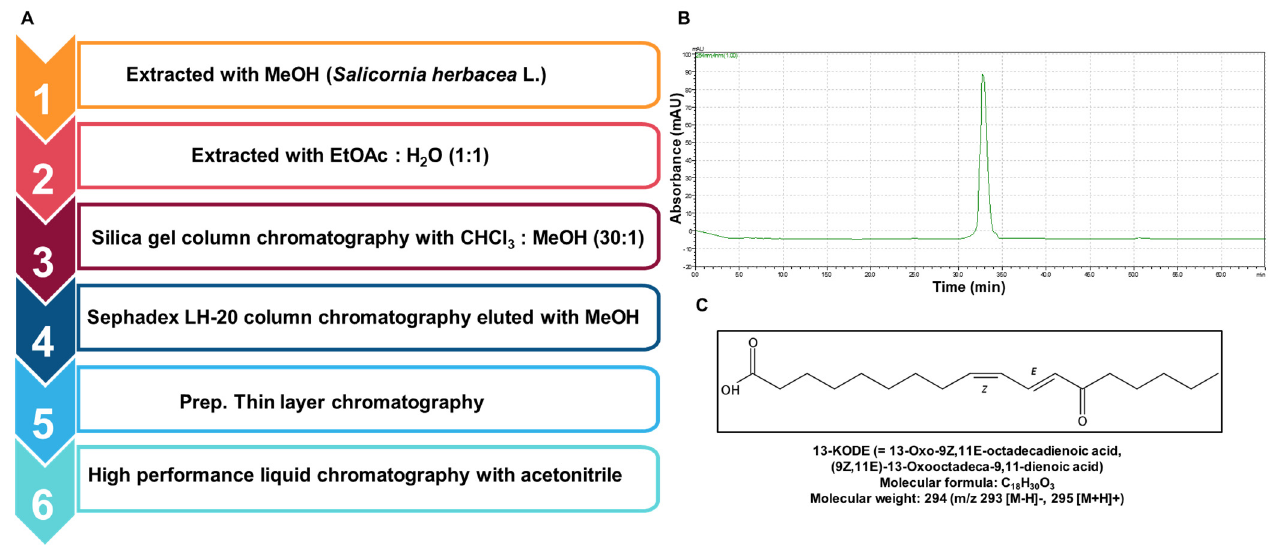
Figure 1. Procedure for the isolation of an antioxidant from S. herbacea L. and the molecular structure of 13-KODE. ( A ) Purification flowchart of the antioxidant from S. herbacea L. ( B ) HPLC analysis of an antioxidant derived from S. herbacea L. ( C ) Chemical structure of 13-KODE, the antioxidant purified from S. herbacea L.